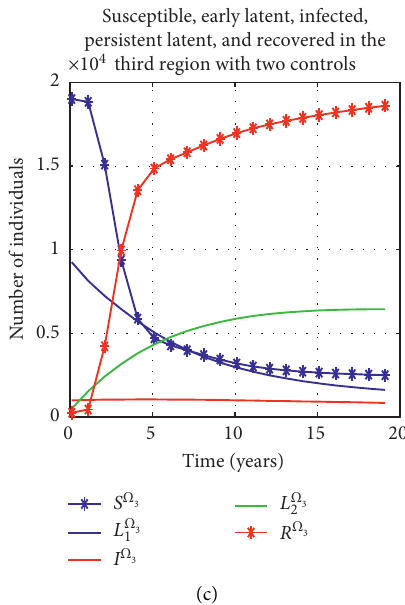
Figure 4: The state variables in three regions with BCG vaccination and travel-blocking